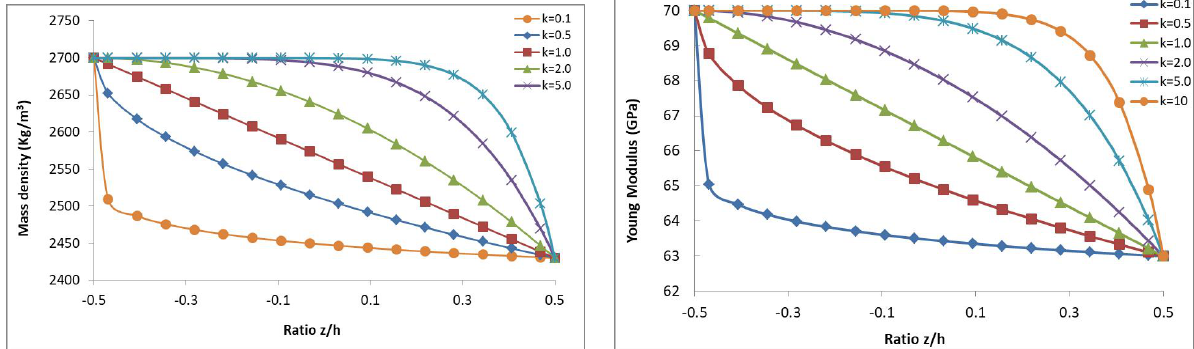
Fig. 1. Variation of material properties at porosity 0.1: (a) Mass density, (b) Modulus of